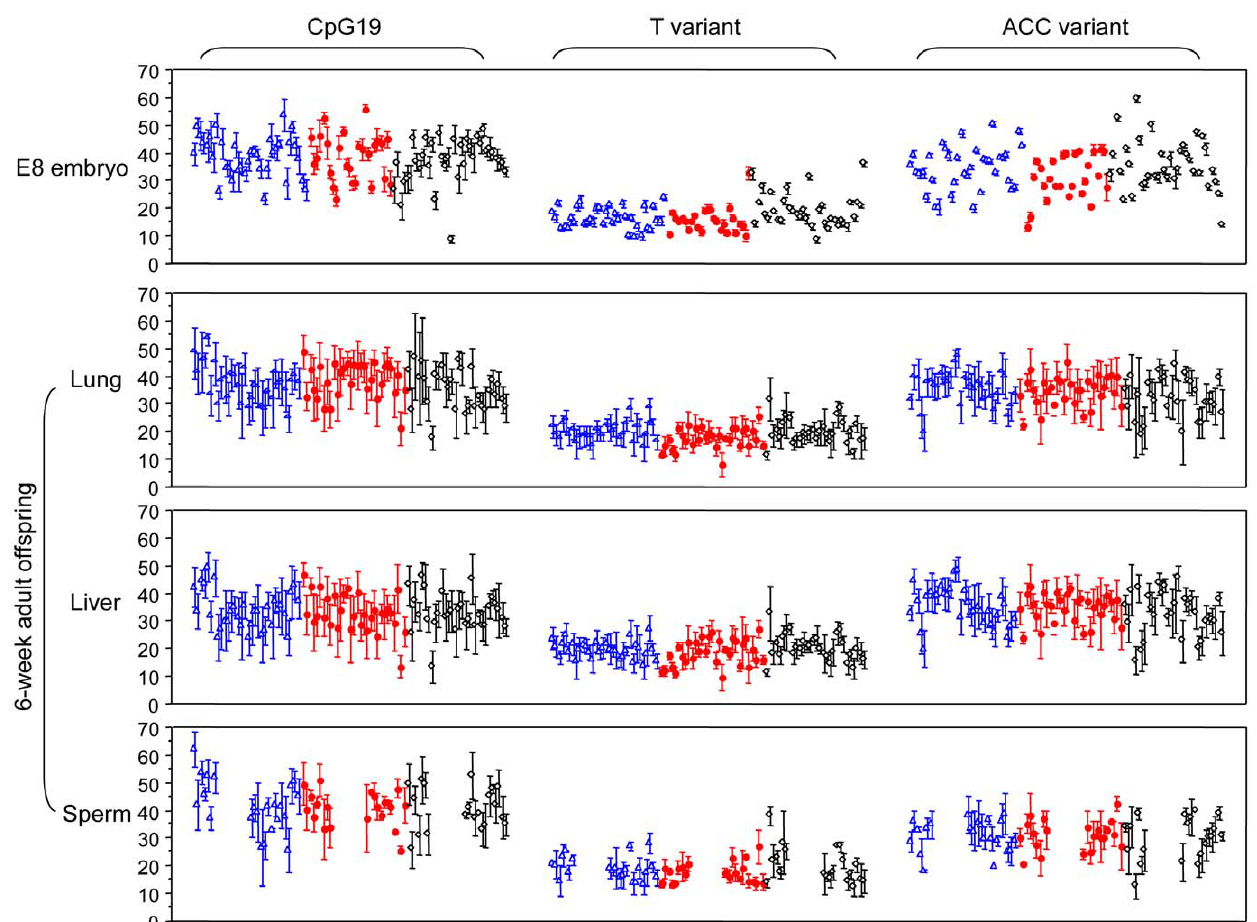
Figure 2. Increase of littermate-to-littermate variation during ontogeny. Within-litter variation, represented by error bars, of rDNA haplotype frequencies (%, T and ACC) and CpG19 methylation (%) widened from E8 embryos to 6-week adult tissues in 3 paternal treatment lineages (genders combined; blue: acidic saline; red: Cr; black: untreated). The average litter size is 9 at E8 embryo and 8 at 6-week adult stage. The plots are displayed as mean 6 1x standard deviation to illustrate the degree of variation.